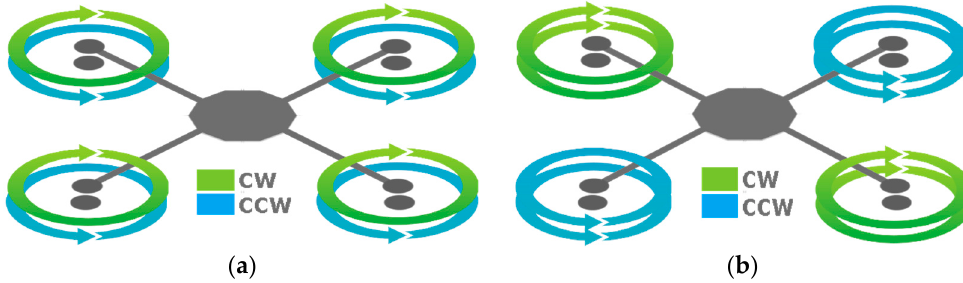
Figure 1. Overlapping rotor propulsion system co-axial quadrotor configurations: ( a ) system torque balanced at all four propulsion units internally; and ( b ) system torque balance achieved externally of the individual propulsion units.